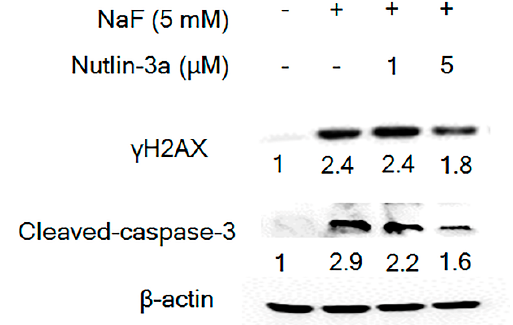
Figure 8. Nutlin-3a ameliorated fluoride-induced apoptosis in LS8 cells. LS8 cells were treated